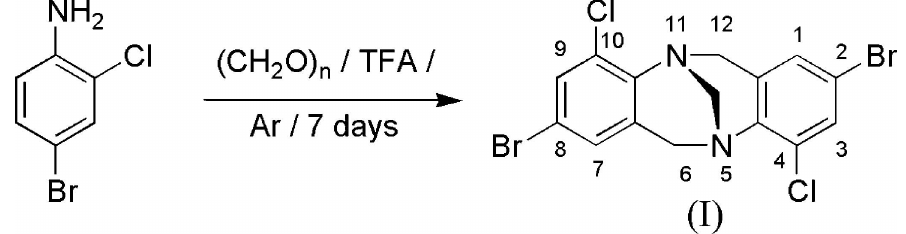
Figure 1 ORTEPII (Johnson, 1976) plot of (I), with ellipsoids at the 10% probability level. H atoms are drawn as spheres of arbitrary radius.